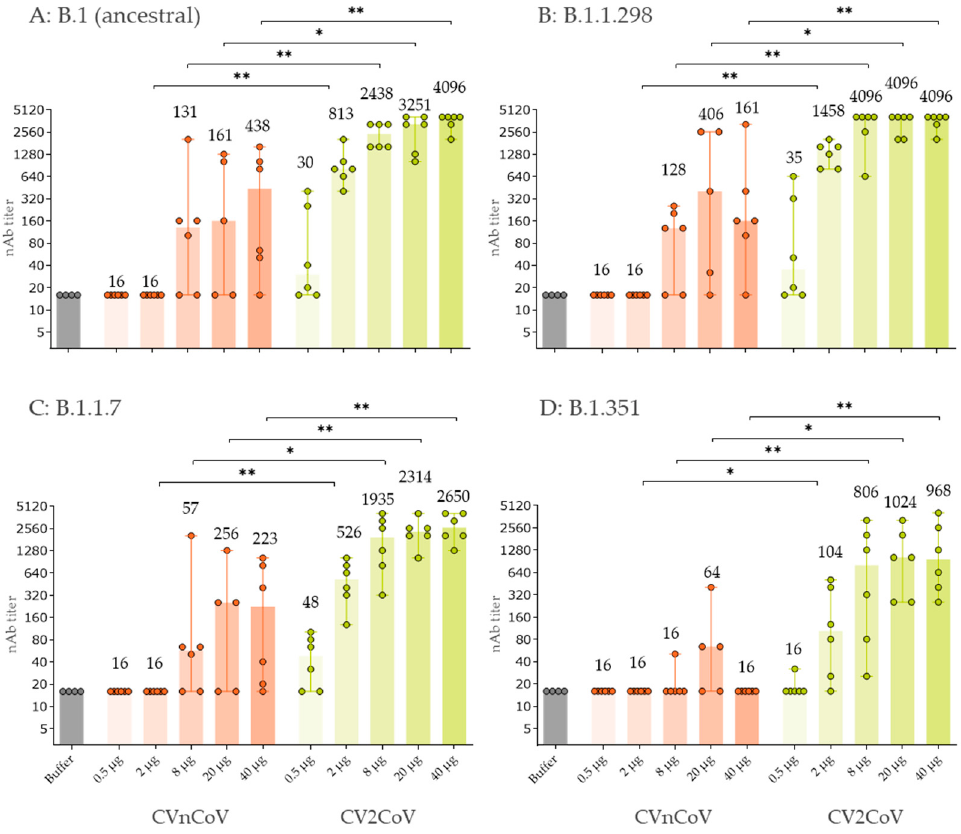
Figure 4. Two doses of CV2CoV on D0 and D21 induced higher virus neutralising antibody (nAb) titres on D42 against ( A ) ancestral SARS-CoV-2 and the variants ( B ) B1.1.298, ( C ) B.1.1.7 and ( D ) B1.351 compared with two doses of CVnCoV. Groups of female and male Wistar rats ( n = 6/group) were vaccinated IM with five different doses ranging from 0.5 µ g to 40 µ g of CVnCoV or CV2CoV on D0 and D21. Rats ( n = 4) vaccinated with 0.9% NaCl (Buffer) served as negative controls. SARS-CoV-2 virus neutralising antibody (nAb) titres in serum samples taken on D42 were analysed. The highest dilution was 1:5120. Each dot represents an individual animal. The median nAb titres are shown above each bar and the vertical lines show the range. Mann-Whitney test was used to compare groups. * = p < 0.05, ** = p < 0.01.